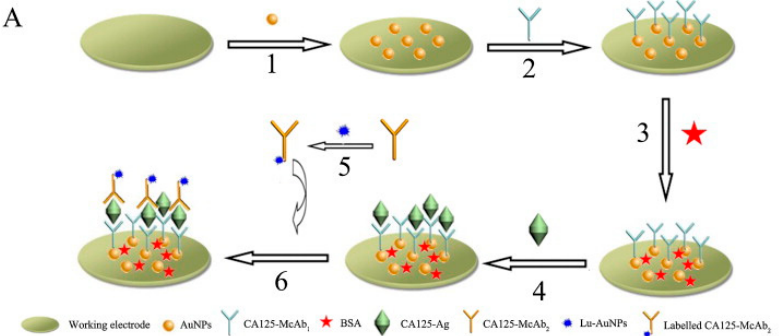
Figure 4. Schematic representation of the fabrication of the ECL CA125 immunosensor and assay procedure described by Wang, S. et al. [80] . Reproduced and adapted with permission of Elsevier.